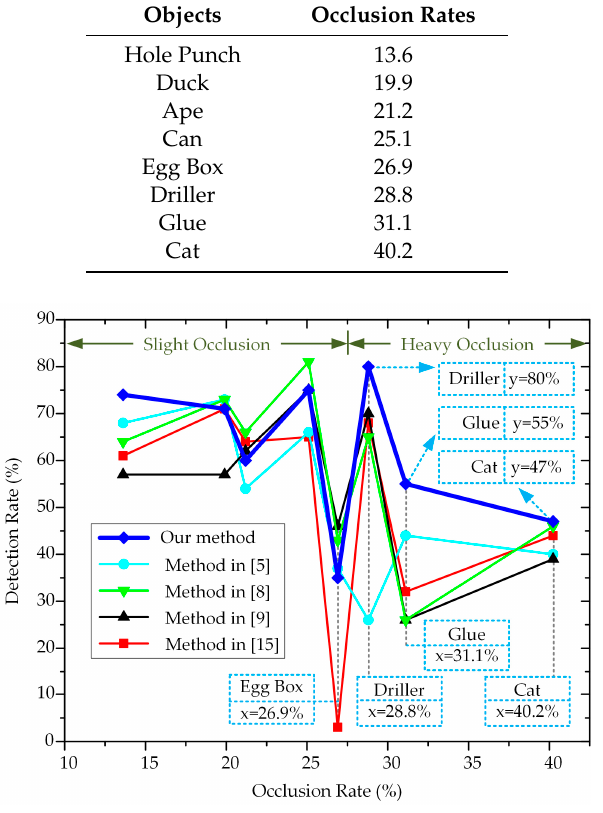
Table 4. Occlusion rate of each object in the Occlusion dataset (%).